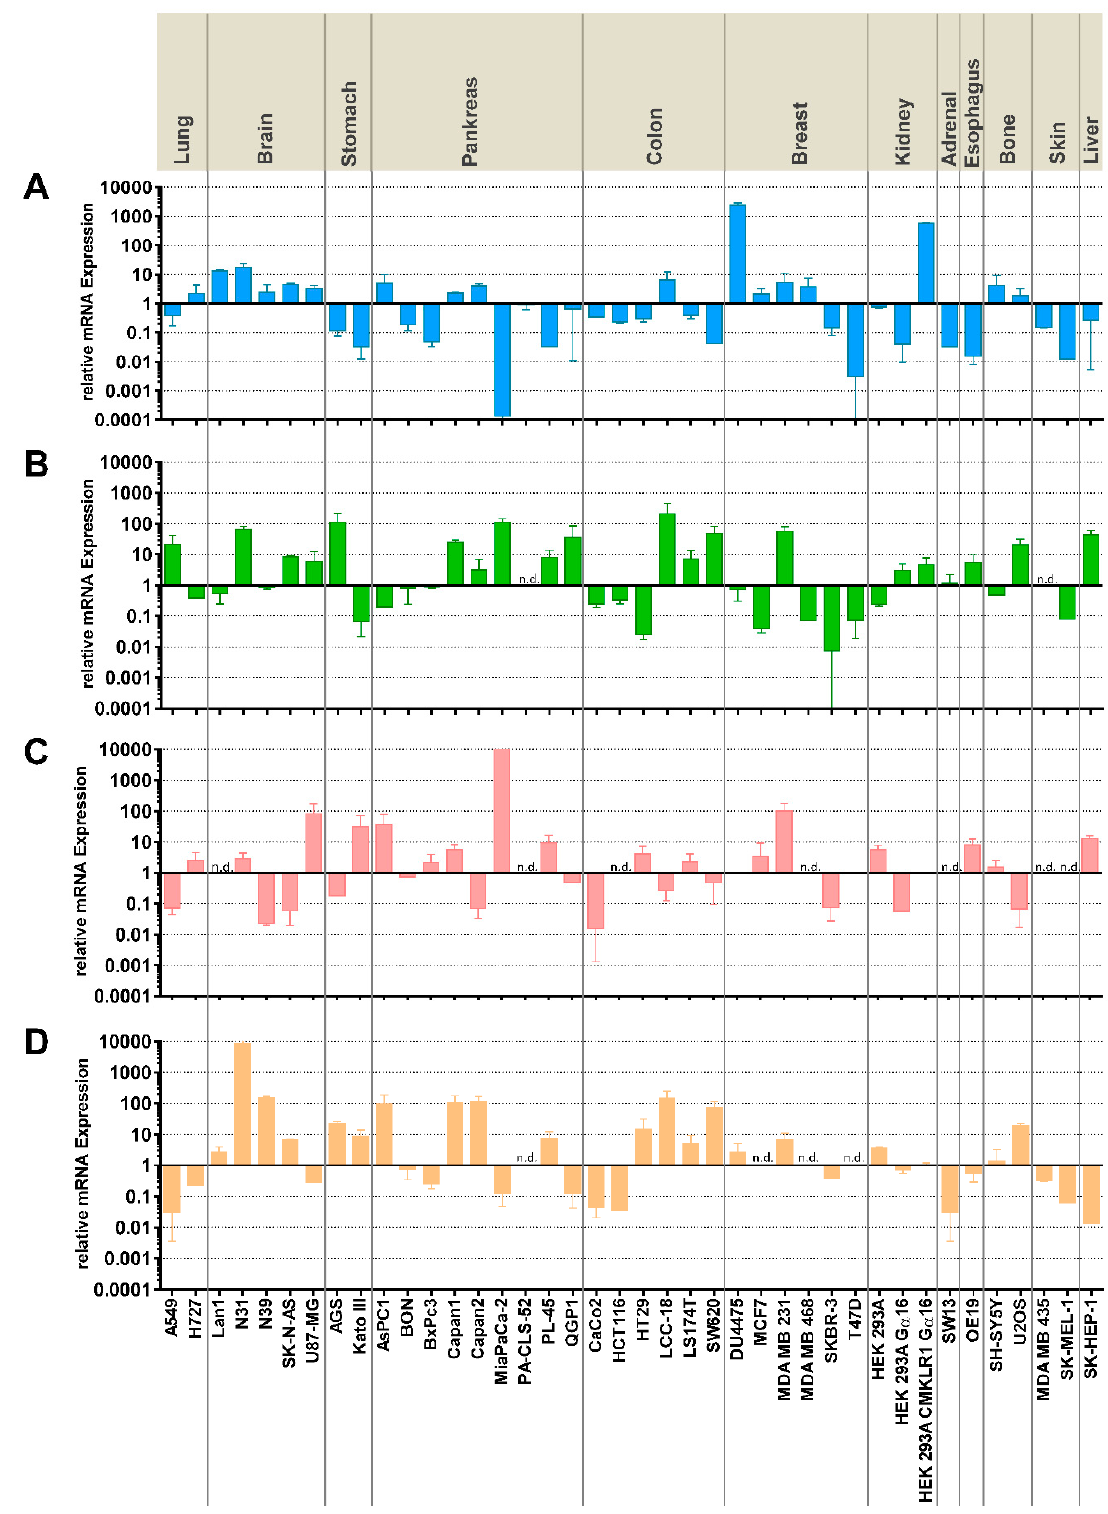
Figure 1. Expression of CMKLR1, GPR1, CCRL2 , and chemerin ( RARRES2 ) mRNA in human colorectal and other cancer cell lines as determined by quantitative RT-qPCR. ( A ) CMKLR1; ( B ) GPR1; ( C ) CCRL2; ( D ) chemerin (RARRES2). The upper section denotes the organ of tumor origin; cell line designations are provided at the bottom. Data have been normalized to reference genes UBC, ALG9, and GAPDH. A value of 1 in the graph corresponds to a cq of 34. All data represent mean ± S.E.M. of n = 2–5 independent experiments; n.d. = mRNA not